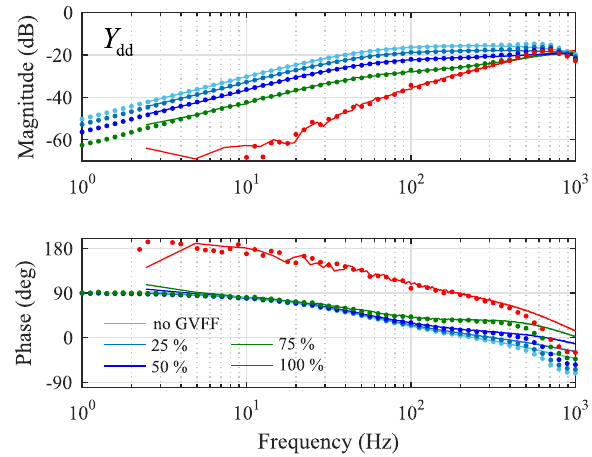
Figure 16. Admittance d-component with different gains for grid voltage